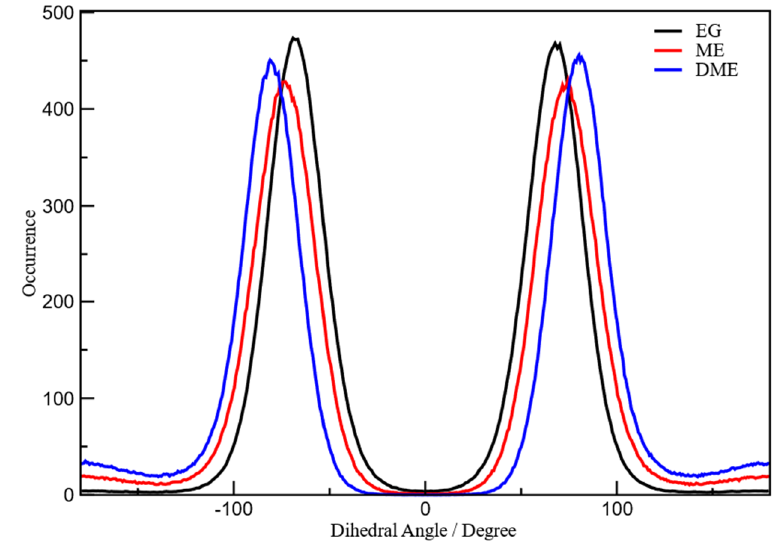
Figure 5. O1–C1–C2–O2 dihedral distribution function.